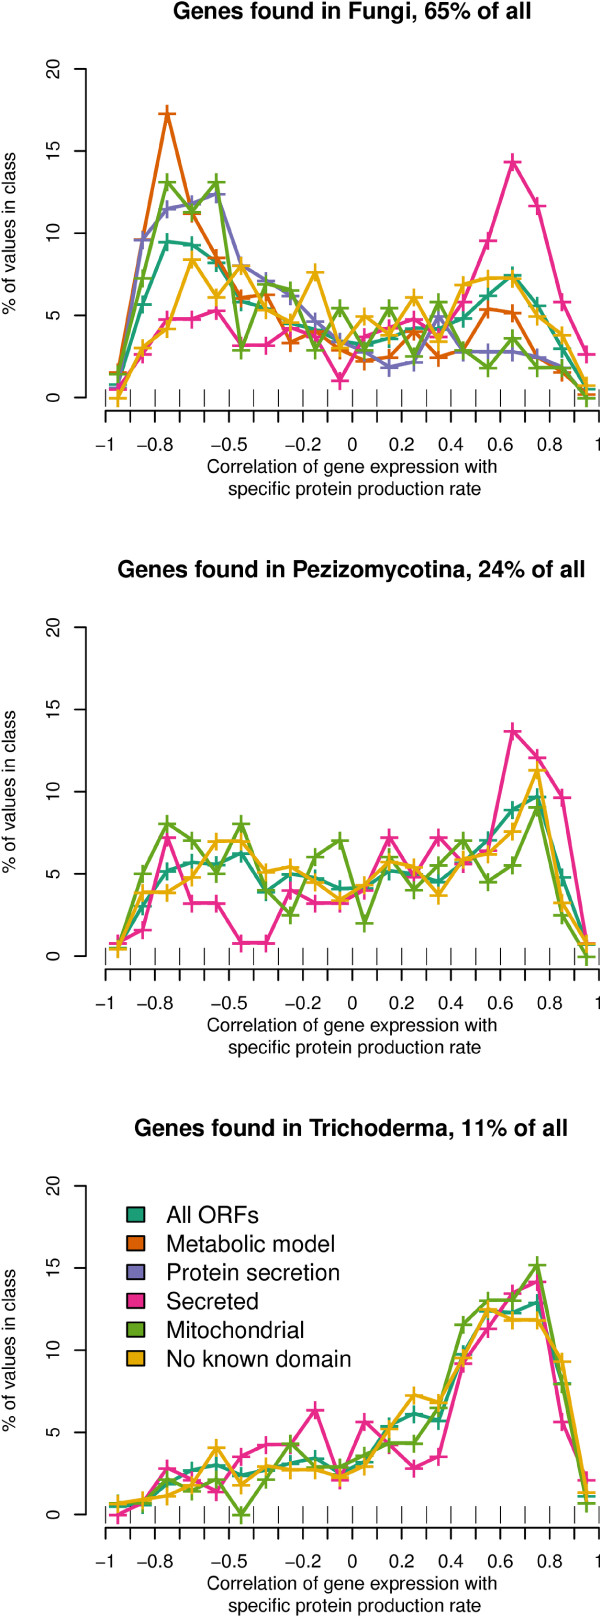
Distribution of correlation of gene expression with SPPR. Genes of T. reesei genome are divided in three plots based on their taxonomic specificity, either found in general in Fungi, only in Pezizomycotina and only in Trichoderma. Each plot shows a distribution for all genes in it and in four different mutually exclusive cellular categories. The Y axis shows the percentage of genes of all genes in the category contained in each bin. The × axis shows the correlation and borders of bins. Plus signs indicate mid values of bins and lines connect them. Cellular categories with at least 50 genes are shown.